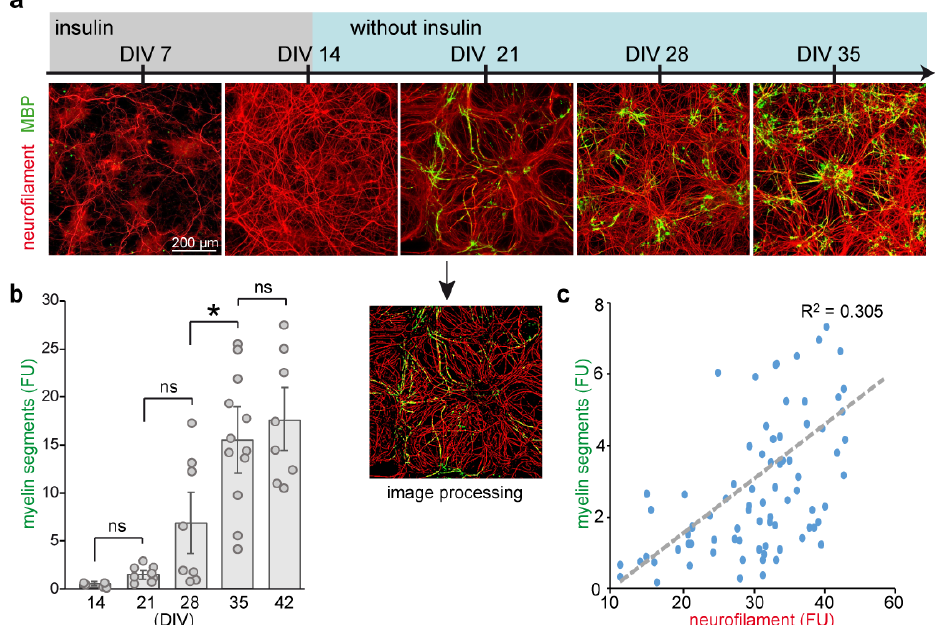
Figure 1. Characterization of myelinating culture derived from E12.5 mouse spinal cord. ( a ) Dissociated cells from embryonic spinal cord were grown on poly-L-lysine coated 96-well plates supplemented with insulin (up to DIV 14). Progression of myelination over 5 weeks in culture was identified using antibody to intermediate neurofilament heavy chain (NF200; red) and MBP (green), the lineage markers specific for neurons and mature myelinating oligodendrocytes, respectively. ( b ) Quantification of myelination. Overlap MBP signal with NF200 enable to visualize myelin segments. Double immunostained images were processed with a CellProfiler pipeline (example shown for DIV 21) that enables quantification of the pixel area for each signal. Myelin segments were calculated as an overlay of red and green lines. ( c ) At the peak of myelination (DIV 35), the extent of neuronal insulation is proportional to neurite density in individual wells. Data summarized results from three independent experiments ( n = 8). Mean ± SEM. ANOVA followed by post hoc Tukey’s analysis revealed a significant increase in myelination in DIV 28 vs. DIV 21, DIV 35 vs. DIV 28, but not in the late stages (DIV 42 vs. DIV 35). * p < 0.05; ns, non-significant Pearson’s correlation was calculated as R 2 = 0.305. DIV, days in vitro. FU, fluorescent units. Scale bar: 200 µ